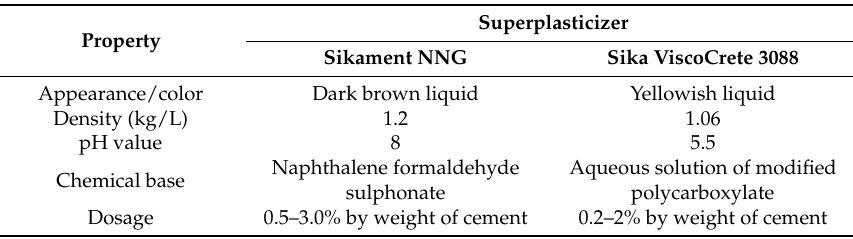
Table 5. Properties of